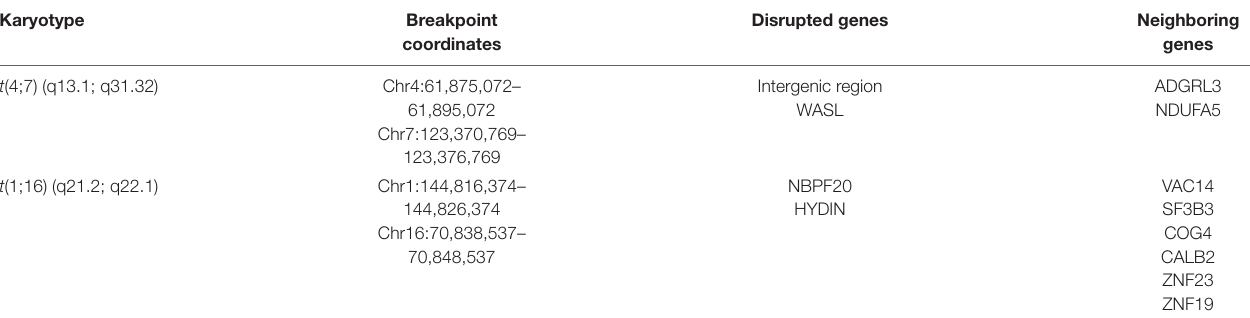
TABLE 1 | Translocation breakpoints and neighboring genes around translocated pairs. Karyotype Breakpoint Disrupted genes Neighboring coordinates